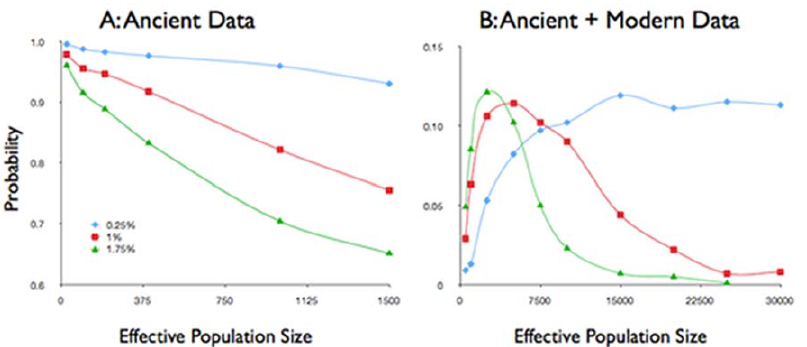
Figure 2. Frequencies with which number of observed segregating sites are simulated under different mutation rate scenarios. A: Results of simulating the number of segregating sites observed in ancient samples from Lamar Cave. B: Results of simulating segregating site frequency found in modern Lamar Valley. Mutation rates represent rate of mutation per base pair per million years.